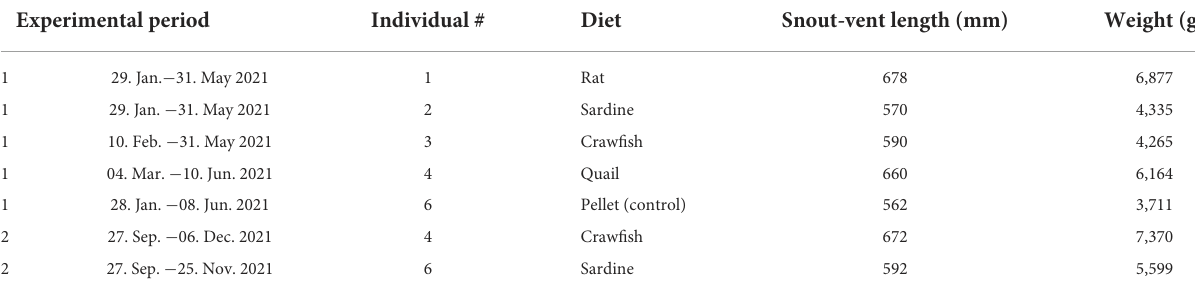
TABLE 1 Overview of experimental animals, experimental period, and diets. Experimental period Individual # Diet Snout-vent length